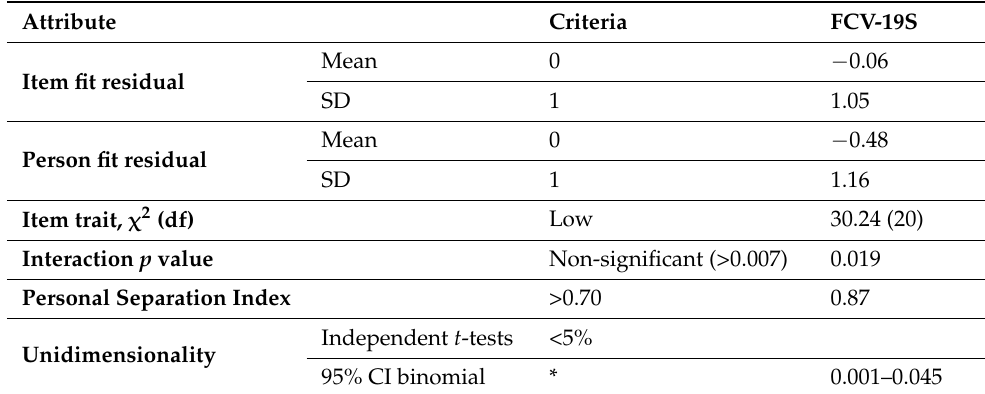
Table 6. Goodness of fit to the Rasch model of the FCV-19S after removing items 1 and 7.